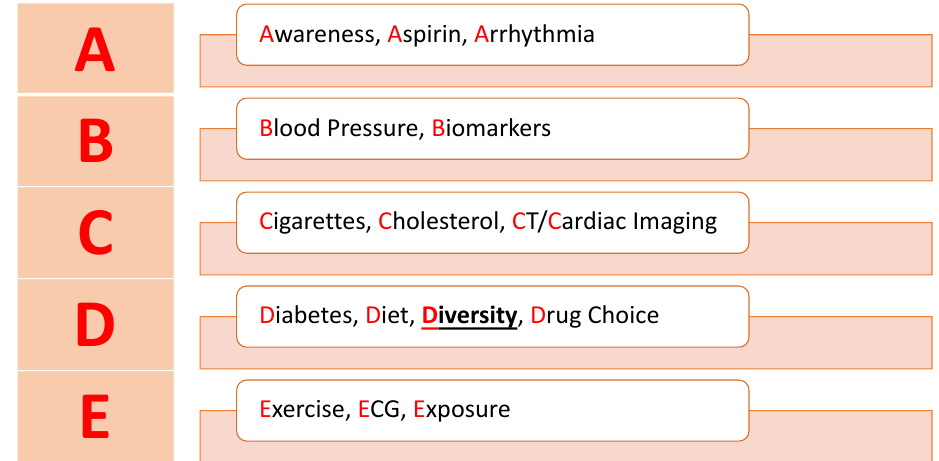
Figure 3. Modified ABCDE algorithm. See newly added “Diversity” under the “D” section.